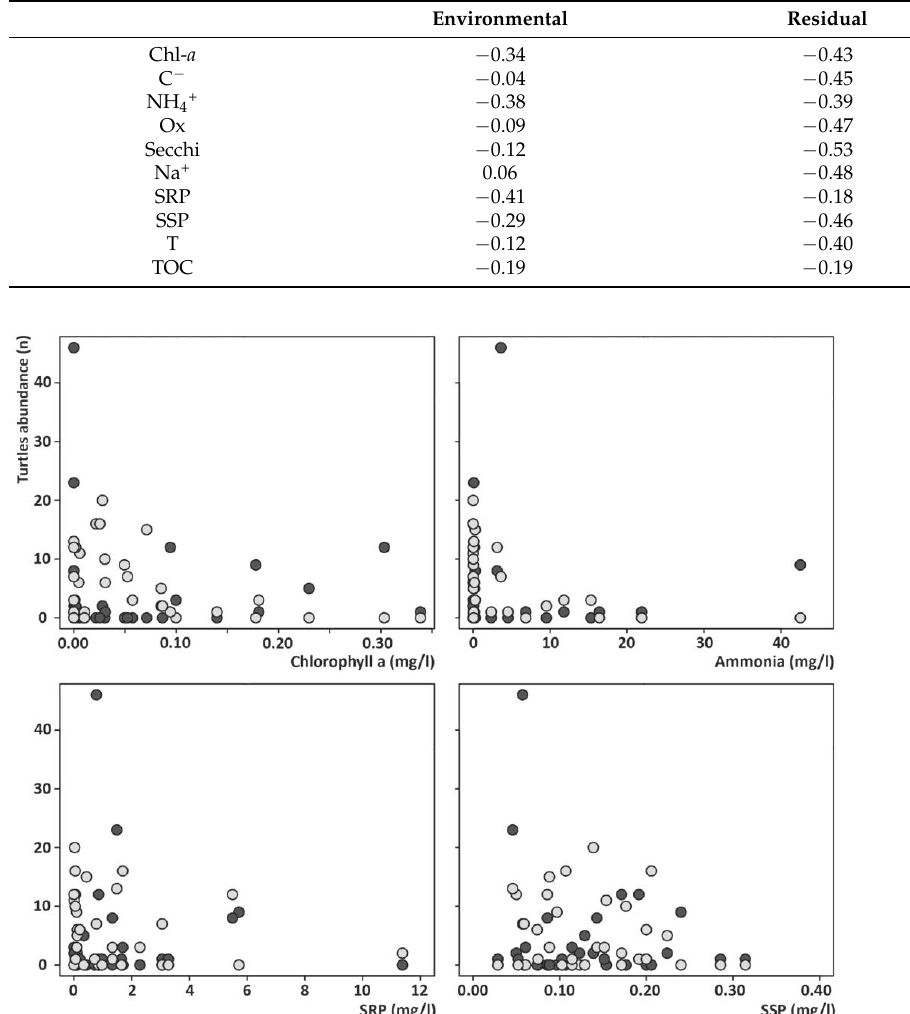
Figure 5. Species abundance along the main environmental variables (i.e., those showing statistically significant relationships with the species distribution). Pale gray: M. leprosa ; dark gray: T. s. elegans . SRP: soluble reactive phosphorous concentration; SSP: suspended solids. The best model explaining the distribution of M. leprosa included the following